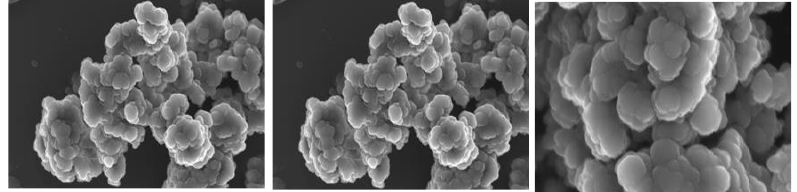
Figure 1. SEM micrographs of dry AgNPs.